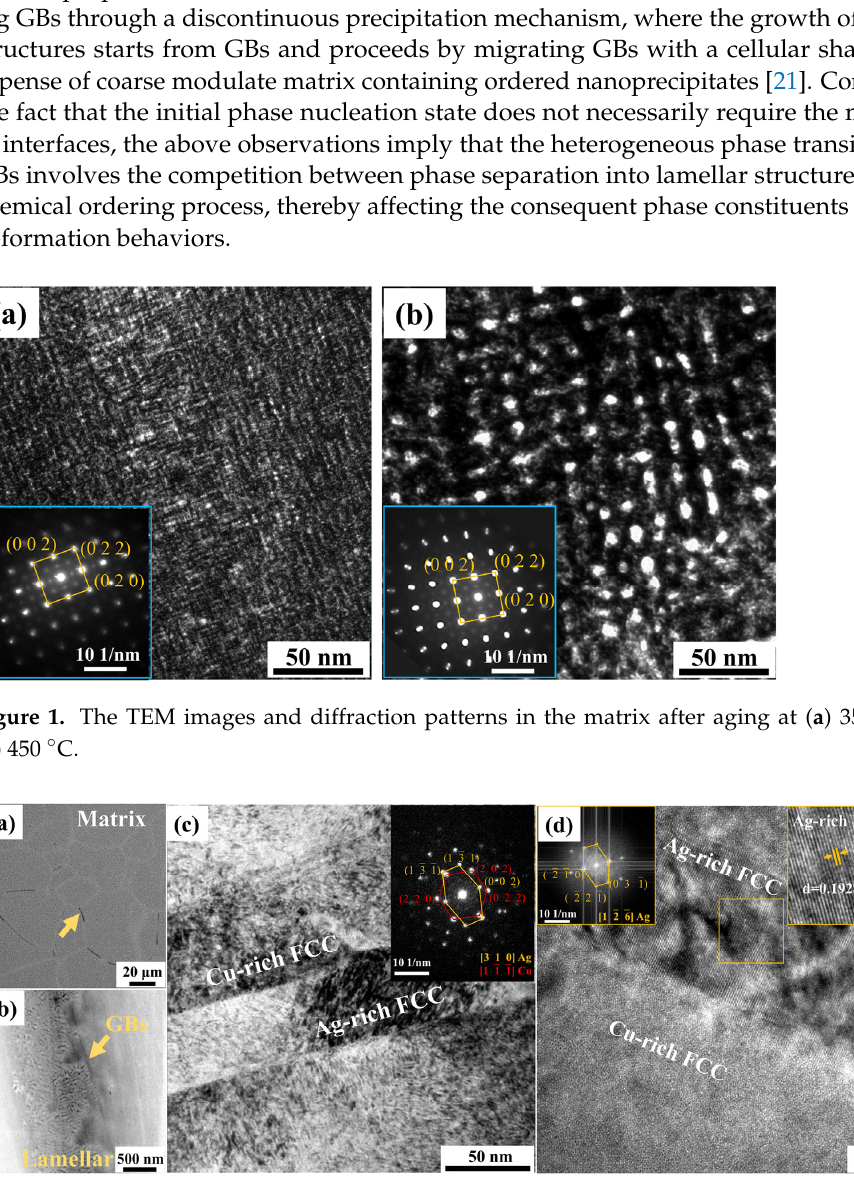
Figure 2. Experimental characterization of the GB phases in samples after solution treatment and isothermal aging at 350 °C. ( a ) The SEM image of the microstructure. ( b ) The locally enlarged SEM image of the lamellar structure near GBs; ( c ) The TEM bright field image of the lamellar regions with corresponding diffraction patterns showing FCC structures of Ag-rich and Cu-rich phases; ( d ) The HRTEM micrograph of GB phases with corresponding diffraction patterns obtained by FFT.